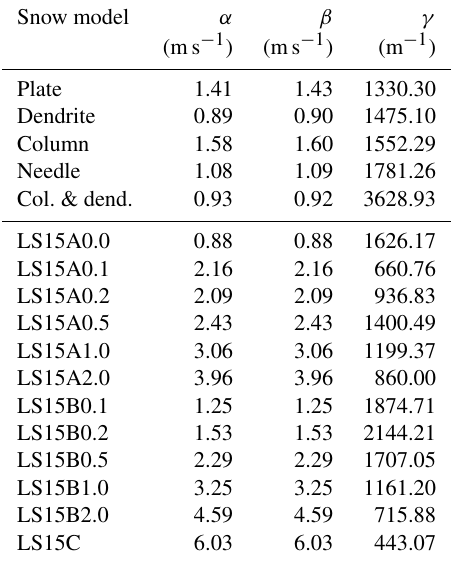
Table 2. Coefficients of the Atlas-like velocity–size relation (Eq. 6) for different snow